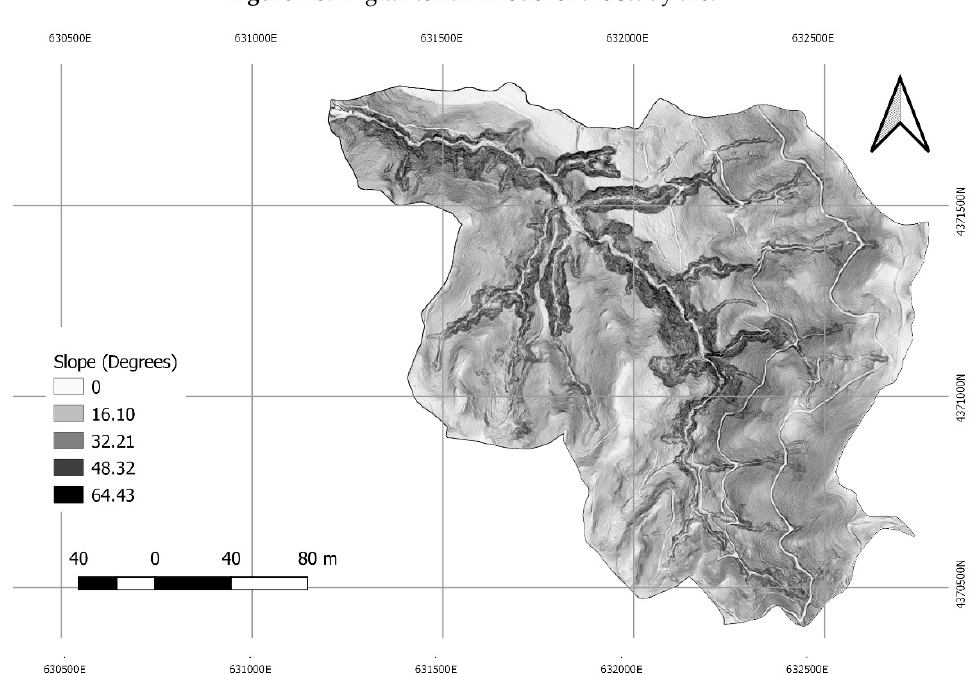
Figure S6. Slope map of the study area